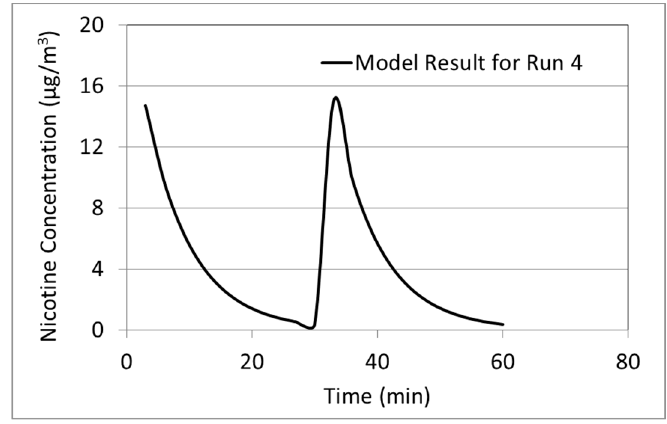
Figure 2. Modeling result for nicotine concentration in the room over time for Run 4 of study by Czogala et al. [26].